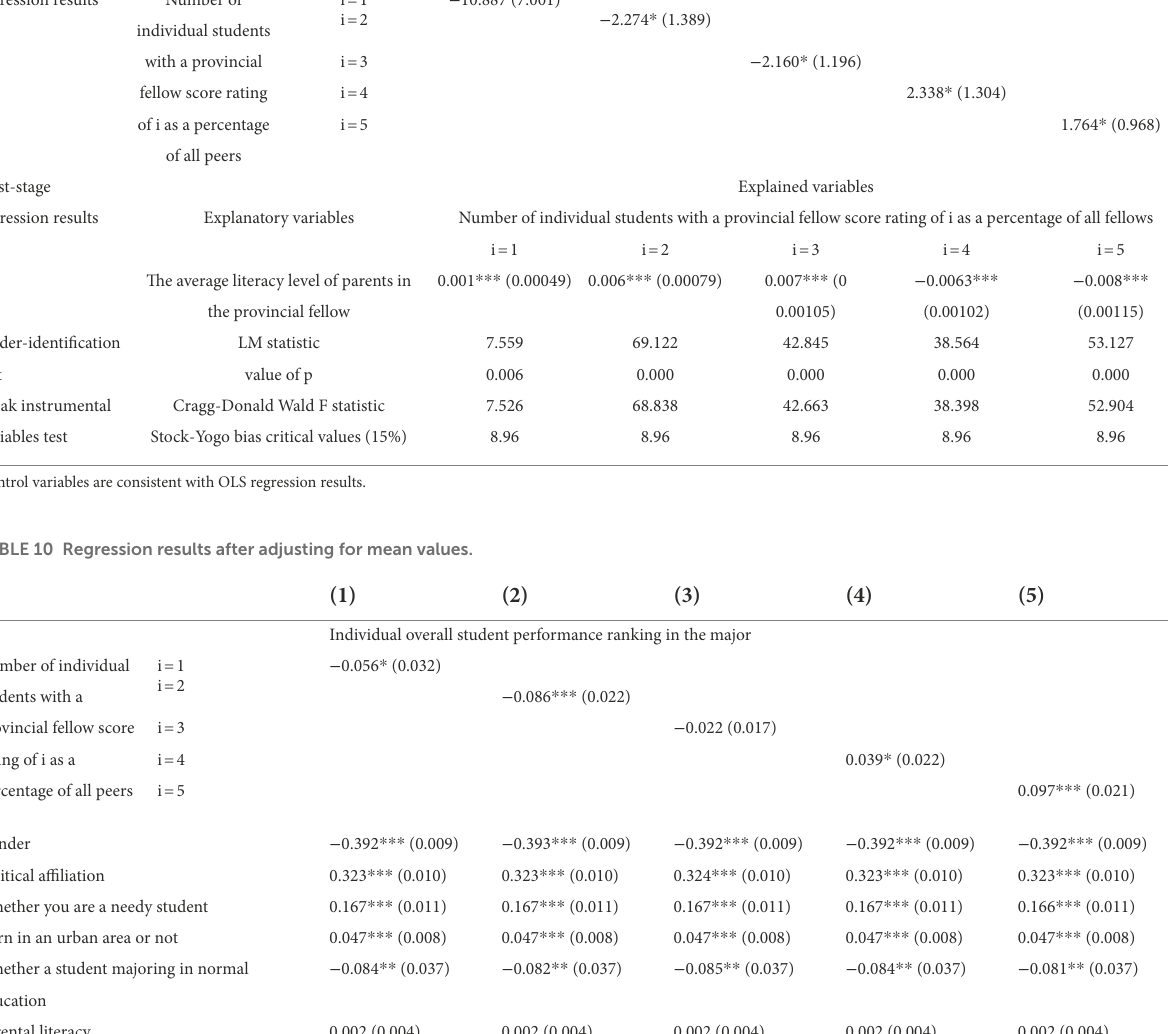
TABLE 9 Two-stage regression results for instrumental variables.